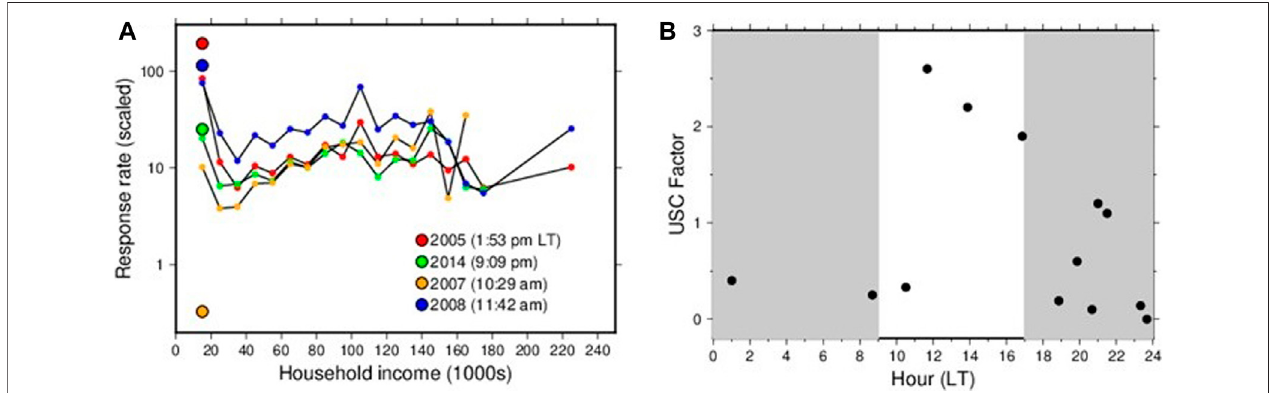
FIGURE3|(A,left) Bin-averagednormalizedresponserateversusaveragehouseholdincomeineachZIPcodeforfourearthquakes,threethatoccurredbetween 9:00am and 5:00 pm local time (blue, red, and orange symbols), and one that occurred around 9:00pm (LT) (green symbols). The large dot shows the normalized responserate in ZIP code 90,089for all four earthquakes (B, right) The USC Factor, for each event in southern California, de fi ned by theratiobetweenRR ZIP for the ZIP codecorrespondingtotheUniversityofSouthernCaliforniaandaverageRRforallZIPcodeswithaveragehouseholdincomebelow$20,000,plottedversustimeof day (local time). Unshaded region indicates standard work-day hours: 9:00am – 5:00pm (LT).